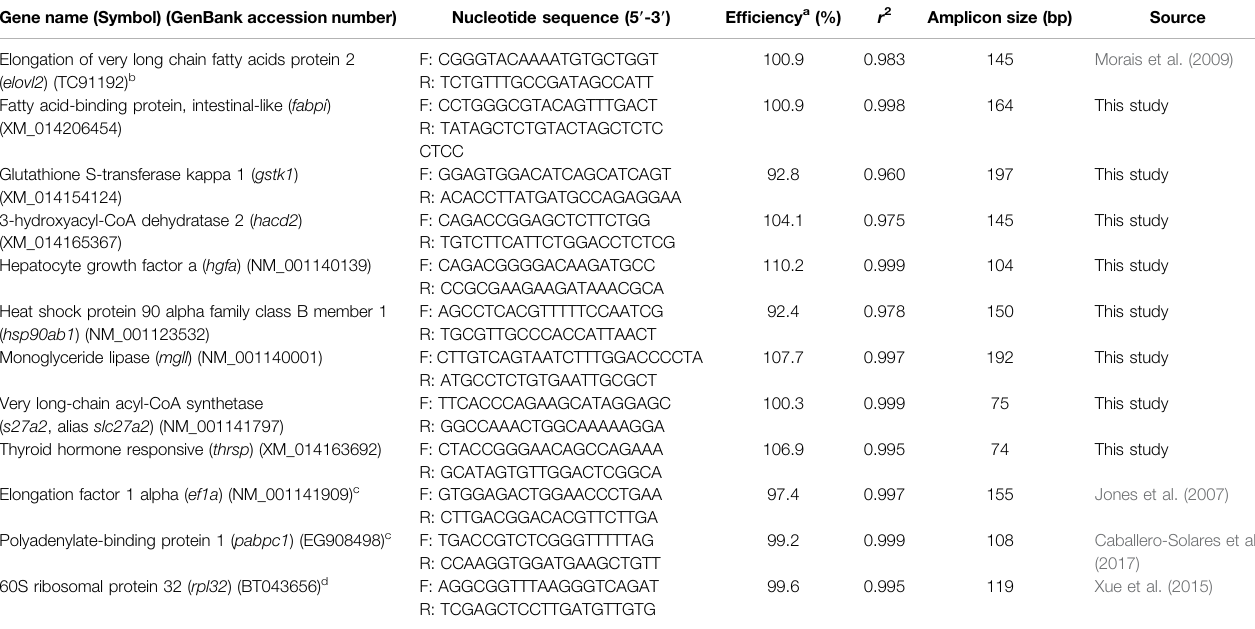
TABLE 2 | RT-qPCR